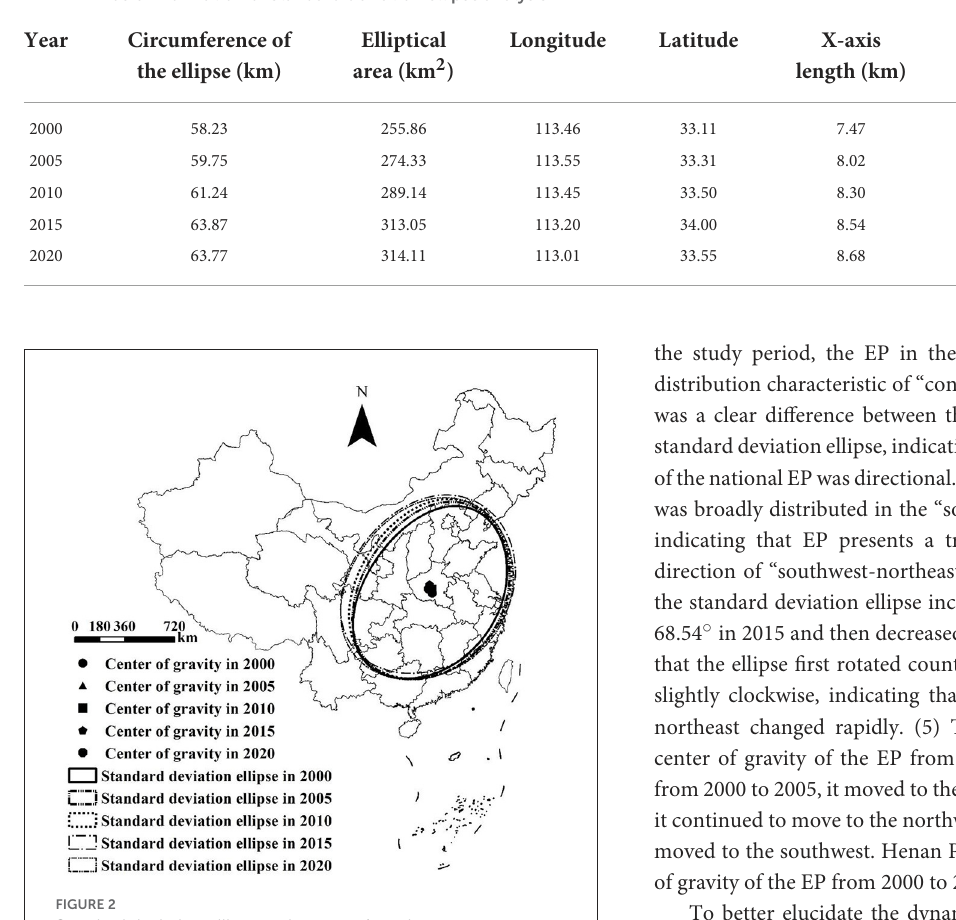
FIGURE2 Standard deviation ellipse and center of gravity movement trajectory of China’s environmental pollution index (EP) from 2000 to 2020.